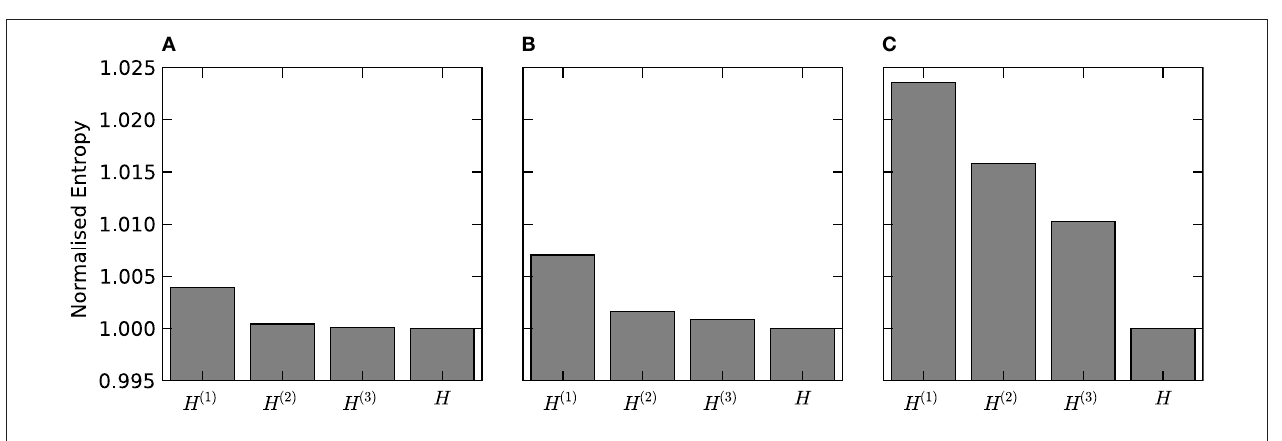
FIGURE 3 | Response entropy of a VPm neuron to white noise vibrassa stimulation. The full response entropy [ H ( R ) denoted H in the fi gure] is shown together with that of maximum entropy models preserving fi rst [ H (1) ], fi rst and